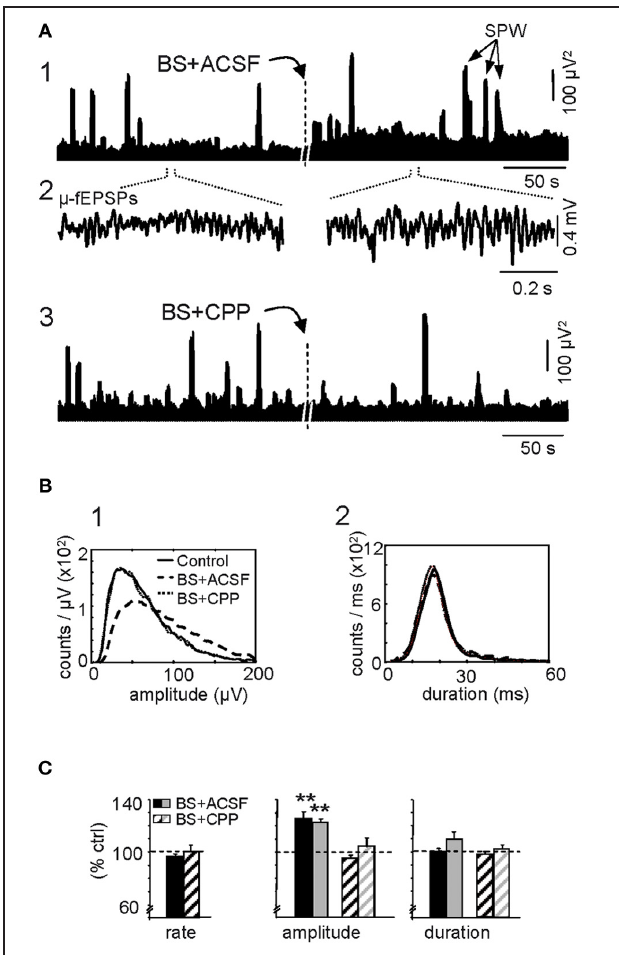
FIGURE 3 | Augmentation of ongoing Schaffer-CA1 input following LTP. LTP is expressed as a sustained increase in the amplitude of spontaneous μ -fEPSP events during irregular (non-theta) LFPs. (A) The burst stimulation (BS) protocol applied to the ipsilateral CA3 produced a sustained population increase in the power of the reconstructed Schaffer LFPs (the plots illustrate two short epochs taken 10min before and 1h after BS, analyzed together by ICA) (1) . The dashes in the middle marked ∼ 1h period lag, at the beginning of which the BS was applied. Note the larger amplitude of elementary μ -fEPSPs in baseline activity (2) . The BS effect was blocked by prior local application of the NMDA-receptor antagonist CPP in the stratum radiatum of CA1 (3) . Large bouts of activity correspond to sharp-wave (SPW) events. (B) Distribution of the amplitude (left panel) and duration of μ -fEPSPs (right panel). Data correspond to 10min epochs each for baseline (control), BS plus vehicle (ACSF) and BS in presence of CPP. (C) Cross-animal quantification of the effect of BS on the rate, amplitude and duration of μ -fEPSPs in the absence (solid bars) and presence of CPP (dashed bars; black and gray colors code for maximum and median values of the distribution, respectively: mean ± sem, n = 6 animals, ∗∗ p < 0 . 01, Student’s paired t